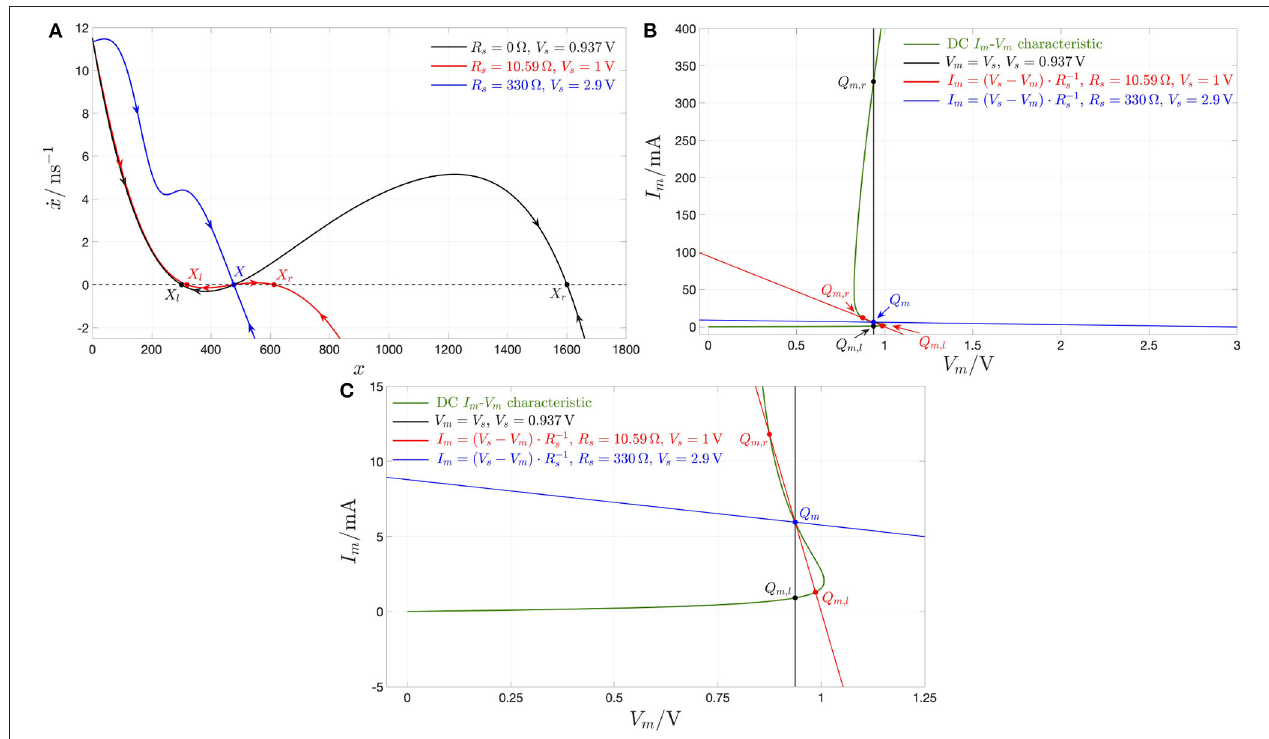
FIGURE 9 | (A) Black curve: State Dynamic Route (SDR) of the memristor under the application of a DC voltage V s 0.937V directly across it. Under these = circumstances, the NbO device is bistable, with the basins of attraction of the left locally stable state operating point X l , lying at 301, and of the right locally stable state operating point X r , lying at 1,601, separated by an intermediate unstable state operating point, X , lying at 478. Importantly, the memristor voltage V m and current I m , corresponding to the state operating point X 478, and identifying the coordinates of a NDR point Q m on the device current-voltage locus, are 0.937V = and 5.948mA, respectively. Red curve: Memristor SDR under the application of a DC voltage V s 1V in the circuit of Figure 8A with R s 10.59 (cid:127) . Under these = = circumstances, the biasing circuit is unable to stabilize the state operating point X 478, which, similarly as in the previous case, separates the basins of attractions of = two locally stable state operating points, i.e., X l 319 and X r 613, located on its left and right, respectively. Blue curve: SDR of the memristor under the application = = of a DC voltage V s 2.9V across the series between a linear resistor of resistance R s 330 (cid:127) and the memristor itself. In this scenario, the memristor features a = = single globally asymptotically stable state operating point, lying at the desired location X 478. (B) DC current voltage-characteristic of the NbO device (green curve), = load line corresponding to the scenario where a DC voltage source of value V s 0.937V is applied directly across the threshold switch (black vertical segment), load = line in the case where a DC voltage source of value V s 1V is applied across the series combination between the memristor and a linear resistor with resistance = R s 10.59 (cid:127) (red negative-sloped segment), and load line for the circuit shown in Figure 8A with V s 2.9V and R s 330 (cid:127) (blue negative-sloped segment). Only = = = the stable operating points, appearing in each of the three scenarios, are highlighted, using filled circles, according to the convention adopted in this article. Importantly, the operating point Q m ( V m , I m ) (0.937V,5.948mA), found to be unstable for ( V s , R s ) (0.937V,0 (cid:127) ) as well as for ( V s , R s ) (1V,10.59 (cid:127) ), becomes = = = = globally asymptotically stable for ( V s , R s ) (2.9V,330 (cid:127) ). (C) Close-up view of plot (b) in the region around the desired NDR operating point Q m = =